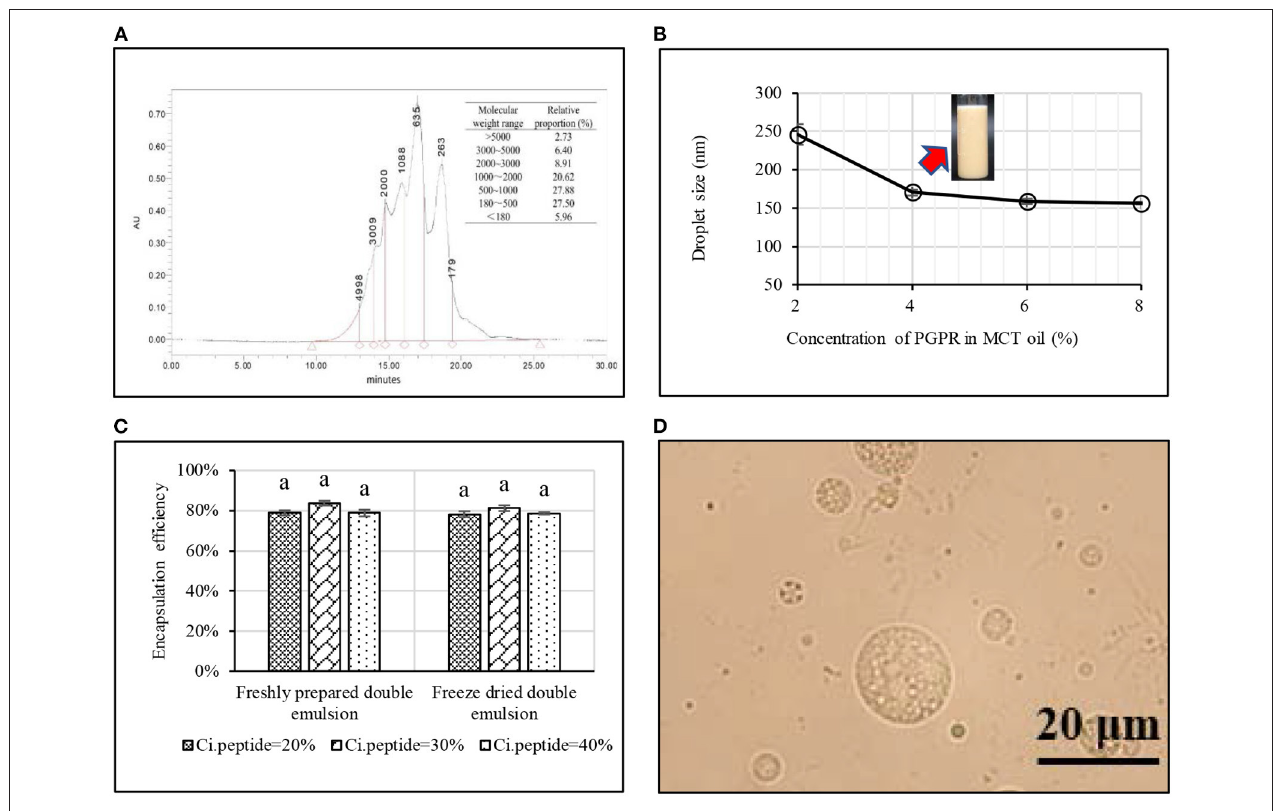
FIGURE 3 | Encapsulation of biopeptides using water-in-oil-in-water (W 1 /O/W 2 ) emulsion (Ying et al., 2021): (A) Molecular weight distribution of soy peptides; (B) Effect of polyglycerol polyricinoleate concentration on droplet size of W 1 /O emulsion; (C) Effect of dehydration technique and peptide content in W 1 phase on peptide encapsulation efficiency in double emulsions; and (D) Morphology of reconstituted freeze dried peptide